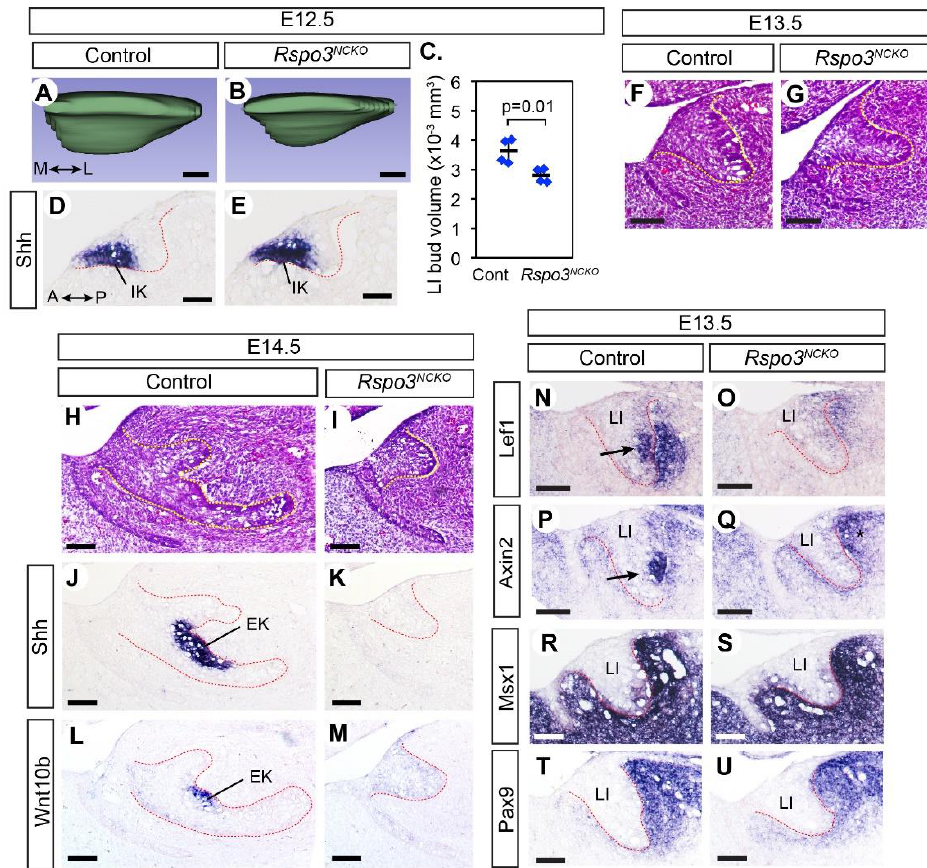
Figure 2. Bud-stage arrest of the lower incisor development in Rspo3 NCKO mutants. ( A , B ) 3D rendering of the lower incisor bud at E12.5. The medial ( M )–lateral ( L ) axis is indicated in ( A ). A total of 8 embryos, one bud per embryo, were examined (4 controls and 4 mutants). ( C ) Comparison of the volume of the lower incisor buds at E12.5. The horizontal bars are the average for each genotype, and the error bars are the standard deviation. Post-hoc power was 0.84. ( D – U ) Sagittal sections of the head processed by RNA in situ hybridization ( D , E , J – U ) or stained with hematoxylin and eosin ( F – I ). All panels show the lower incisor, and the anterior ( A ) – posterior ( P ) axis is indicated in ( D ). The dotted lines mark the epithelium – mesenchyme boundary. For E14.5, 6 embryos (3 mutants and 3 controls) were examined for each experiment. For E13.5, Lef1 was examined in 16 embryos (8 controls and 8 mutants) and Axin2 was examined in 14 embryos (7 controls and 7 mutants). Pax9 and Msx1 were each examined in 6 embryos (3 controls and 3 mutants). Arrows in N and P indicate the expression of Lef1 and Axin2 in the nascent enamel knot. Although Axin2 may appear upregulated in the mesenchyme posterior to the lower incisor bud in the mutant (* in ( Q )), this is due to a slight difference in the plane of section between ( E , G ) and is not a consistent phenotype of the mutant. IK: initiation knot; EK: enamel knot. Bars in ( A , B , D , E ): 0.05 mm; bars in ( F – U ): 0.1 mm. Genotypes of the controls shown are Rspo3 fl/+ ( A , C , D ), Rspo2 +/ − ;Rspo3 fl/+ ( F , N , P , R , T ), and Rspo3 fl/ − ( H , J , L ).